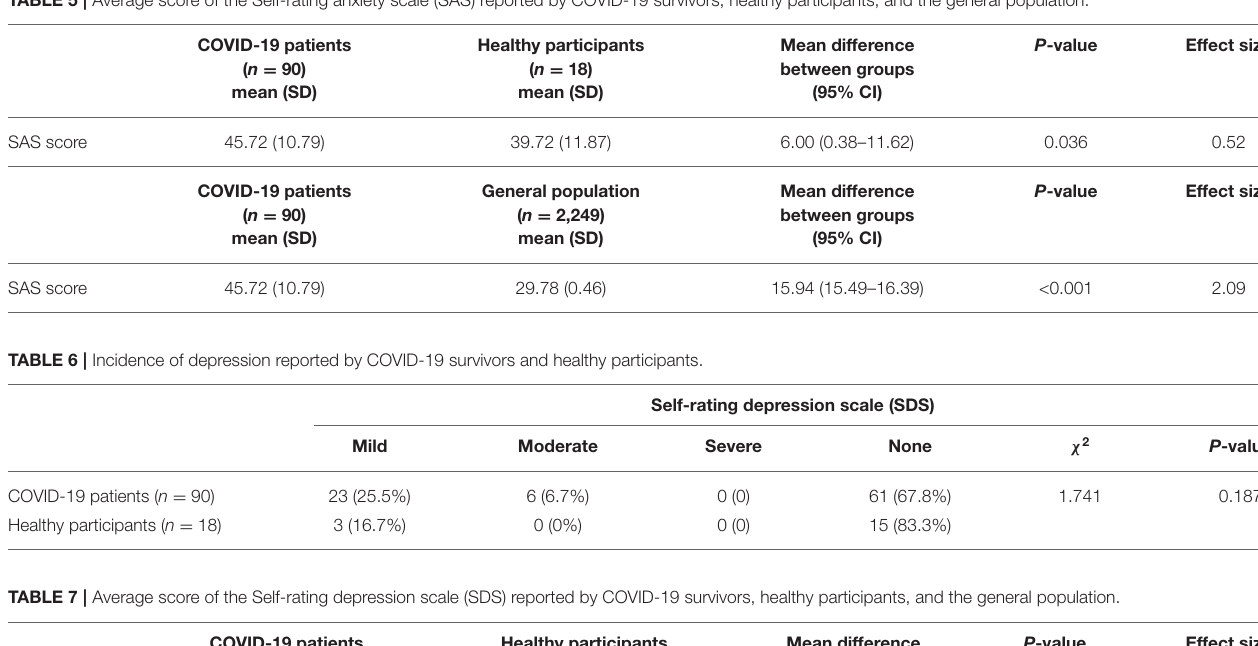
TABLE 5 | Average score of the Self-rating anxiety scale (SAS) reported by COVID-19 survivors, healthy participants, and the general population.